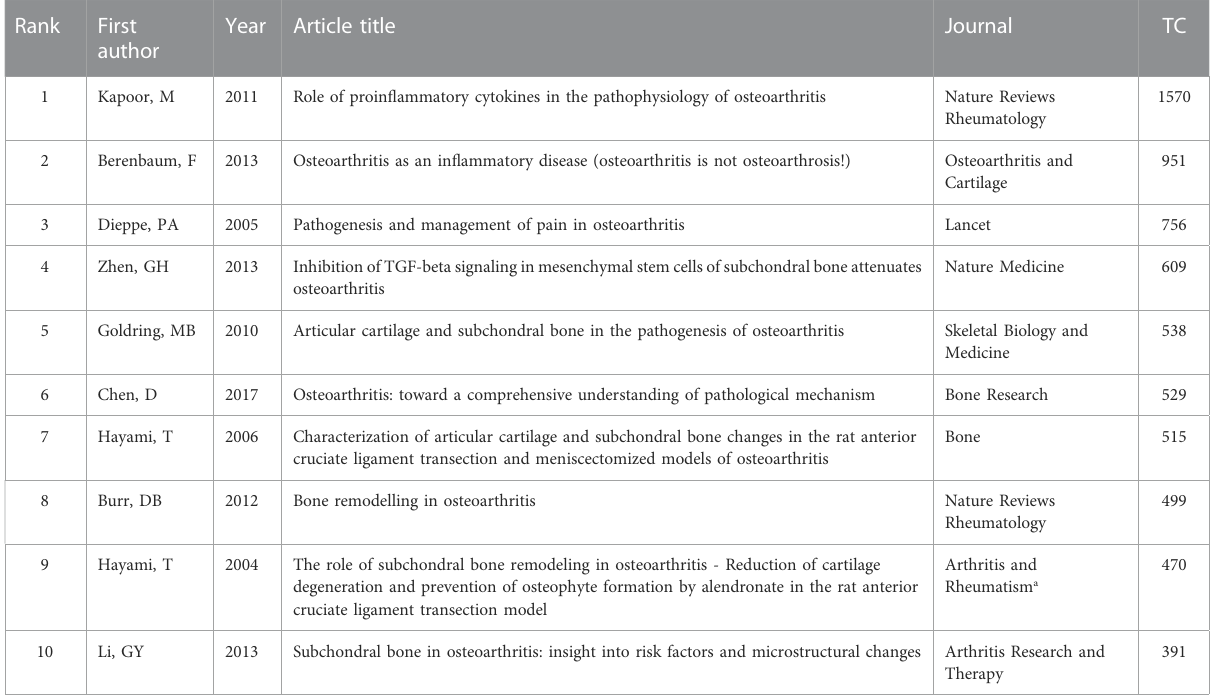
TABLE 5 Top 10 high-cited articles on subchondral bone research in